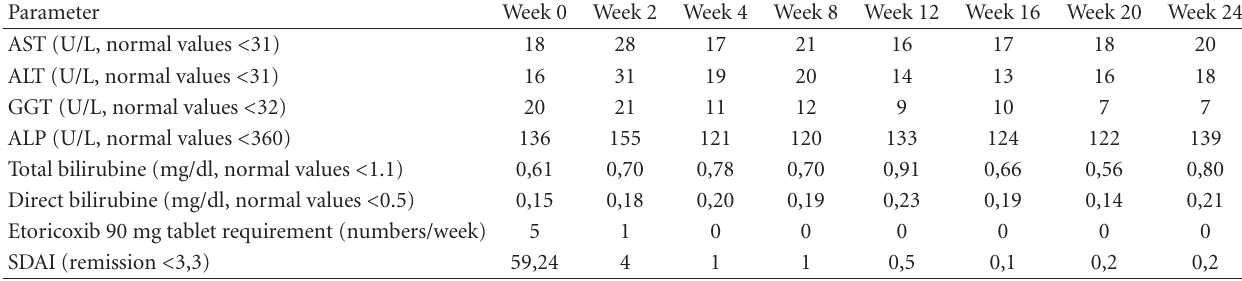
Table 1: Liver function, etoricoxib requirement, and arthritis activity at baseline and during treatment with tocilizumab in a 71-year-old female patient with rheumatoid arthritis and HCV